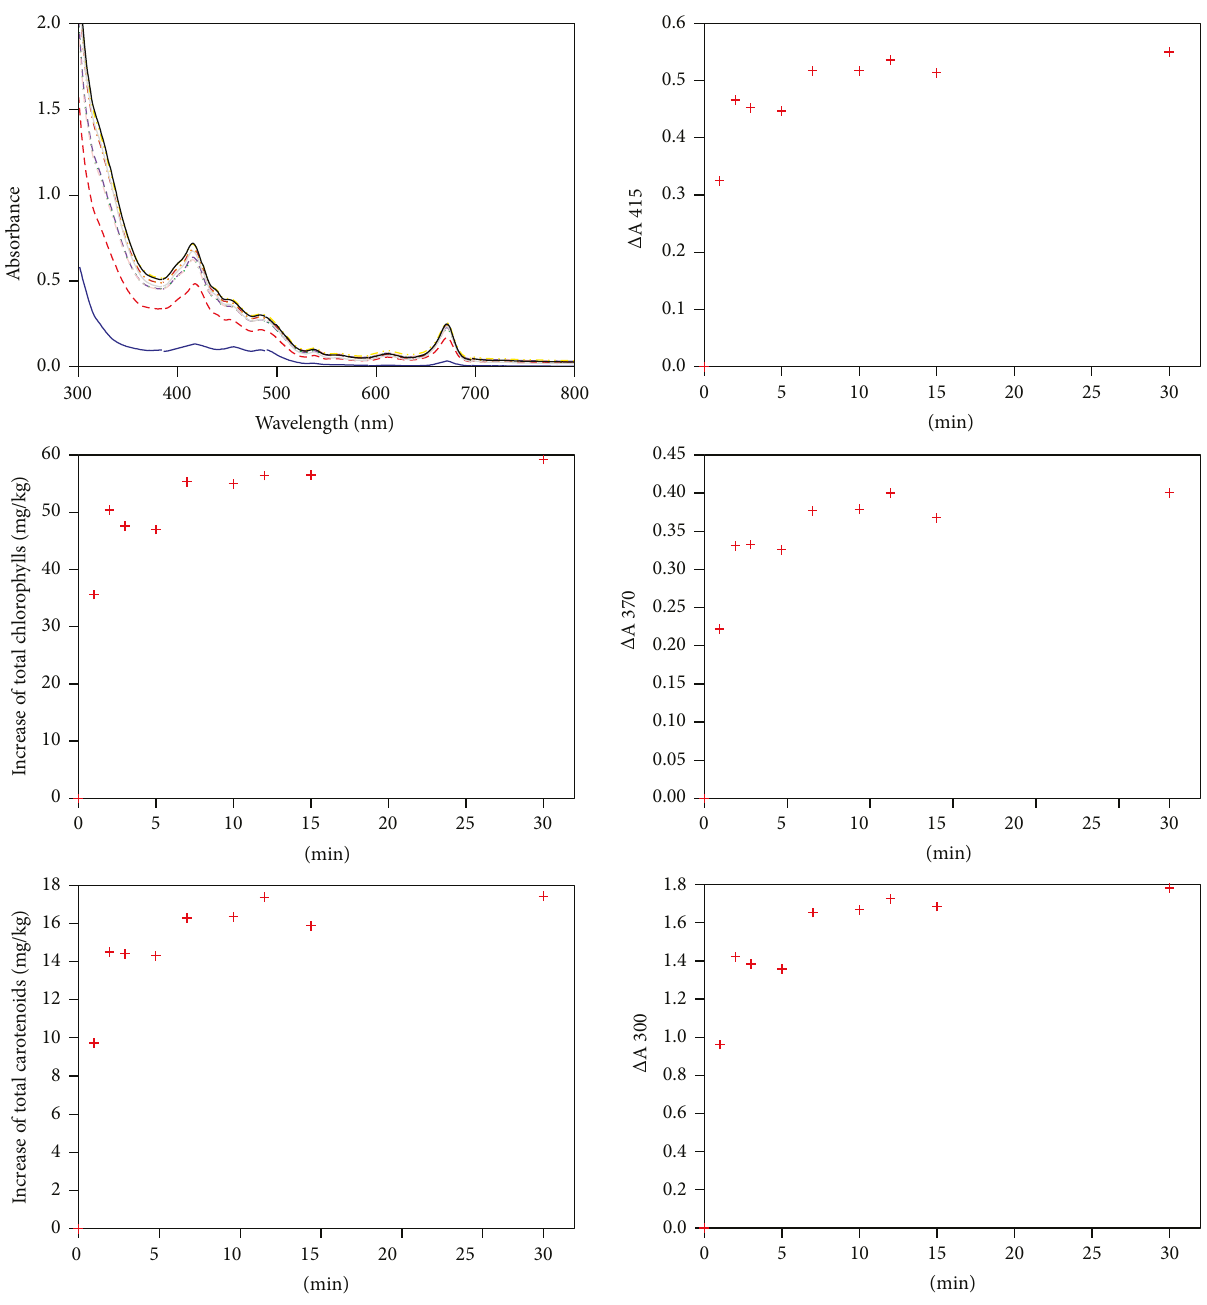
Figure 2: Rosemary ultrasound maceration, results of UV-Vis measurements. For comparison with conventional maceration, see Figure